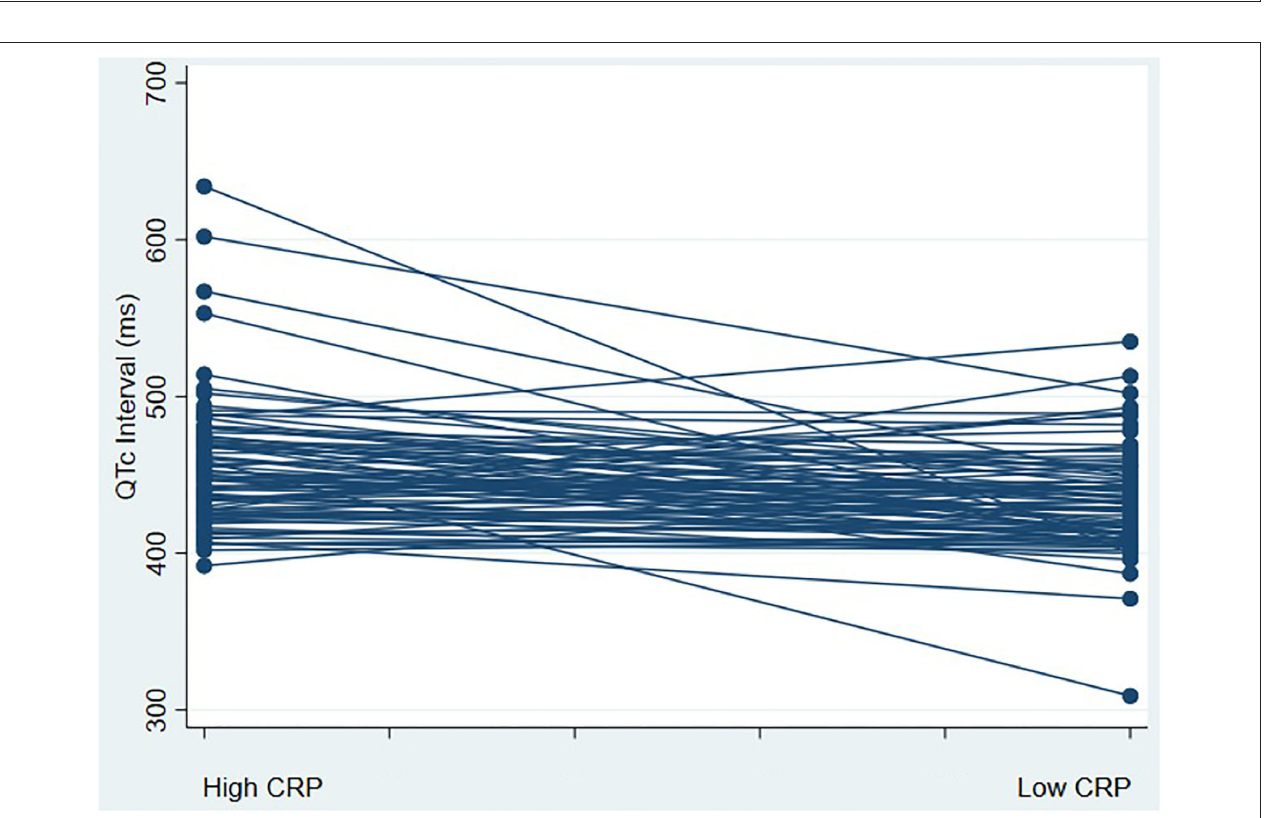
FIGURE 1 | represents the median QTc level ( + /– IQR) during high CRP values (blue), and during low CRP values (red) measured by Bazett, Fridericia, Hodges, and Framingham methods, respectively. The P -Values indicate statistical comparisons of QTc interval between high CRP (blue) and low CRP (red) values. Abbreviations: CRP, C-reactive protein; QTc, corrected QT interval.